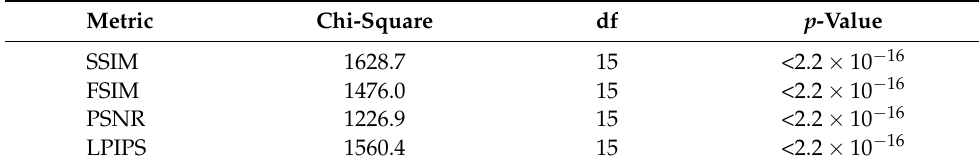
Table A1. The Friedman rank sum test for each of the metrics used.